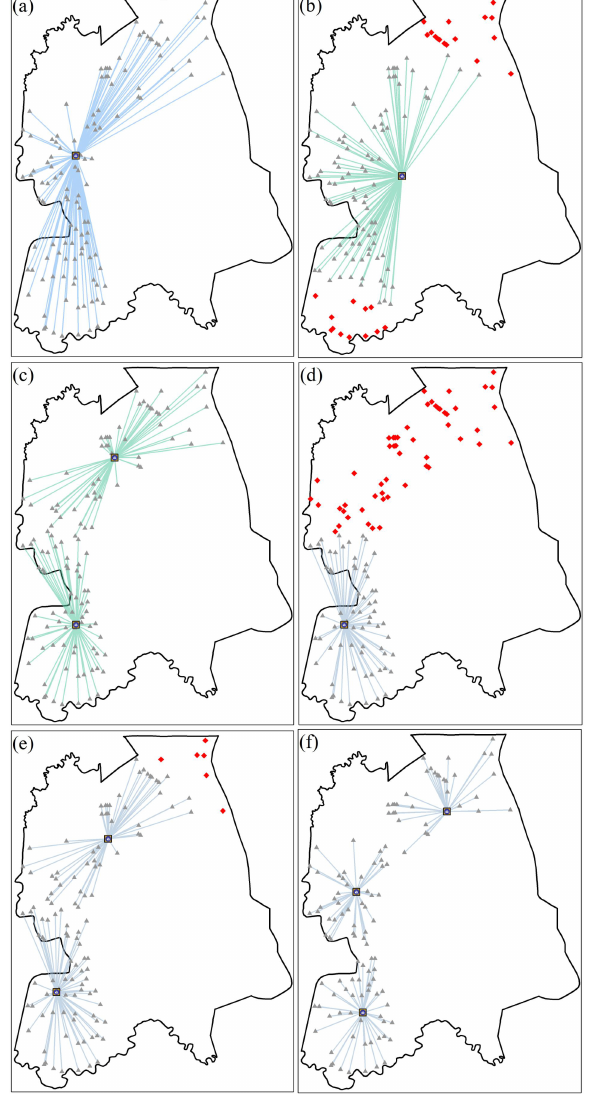
Figure 14. Distribution of wastewater treatment plants of different scales: (a)One big factories; (b)One medium factory; (c)Two medium factories; (d)One small factory; (e)Two factories; (f)Three small